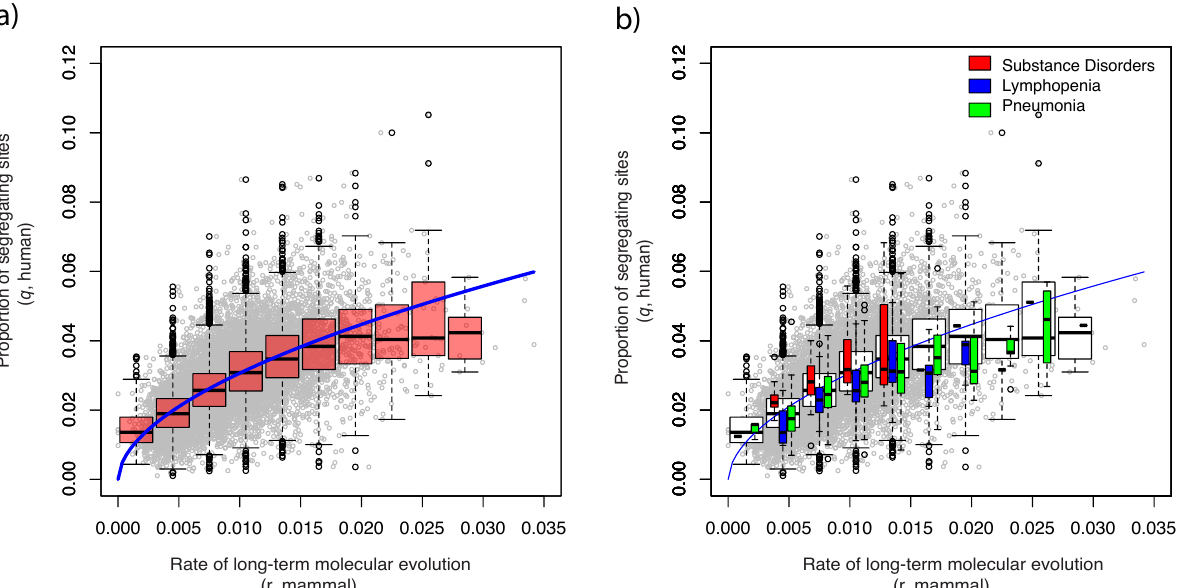
Figure 3. Disease-associated gene set test: ( a ). Scatter plot, boxplot, and regression model of the human proportion of segregating sites (q) vs. mammalian molecular evolutionary rates of 14,671 genes. The blue curve represents the prediction by the negative binomial regression (see Methods). ( b ). Examples of significant disease-associated gene sets in humans revealed by analysis of 14,267 disease-associated gene sets. Genes related to the following diseases in humans are shown as examples: substance-related disorders, lymphopenia, and